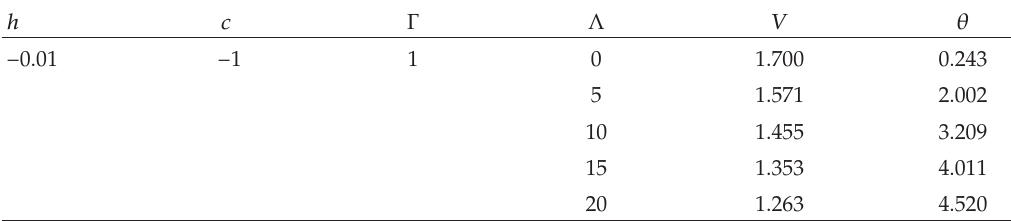
Table 2: Illustrating the variation of the velocity and temperature with Λ